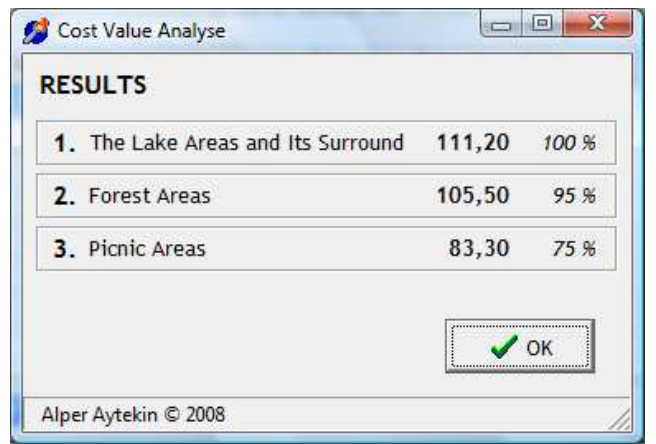
Figure 7. Visualization of the result table by the